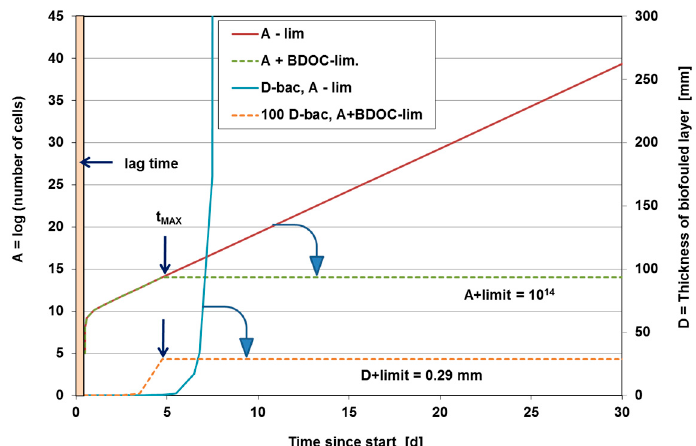
Figure 7. Predicted unlimited (-lim) and carbon limited (+BDOC-lim) growth of bacteria (plotted as